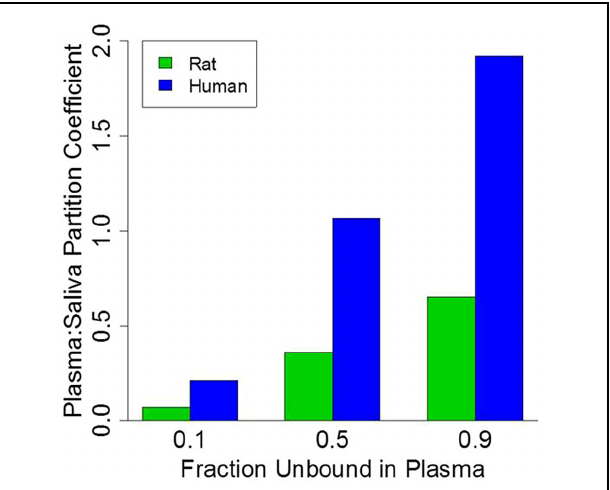
FIGURE 4 | Physiologically based pharmacokinetic model simulation of plasma:saliva partitioning coefficients for three generic compounds with varying plasma